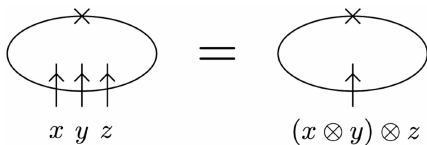
Figure 2 . The vector space on a circle with multiple topological defects is the same as the vector space on a circle with a single topological defect labeled by the tensor product of the topological defects. To determine the order of the tensor product, we need to specify the base point on a circle, which is represented by the cross mark in the above